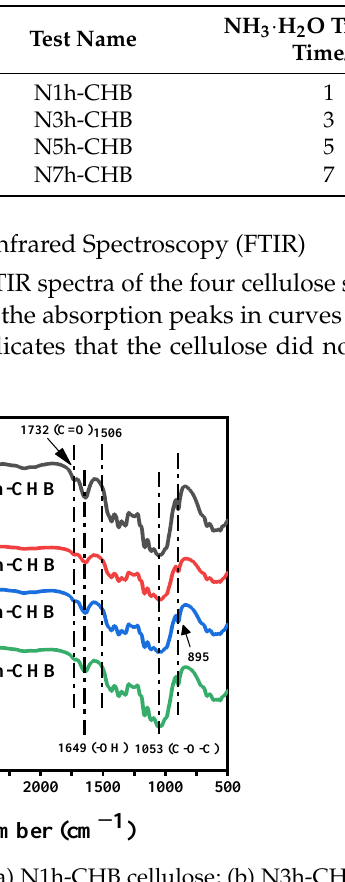
Table 2. Solution preparation and pretreatment method.